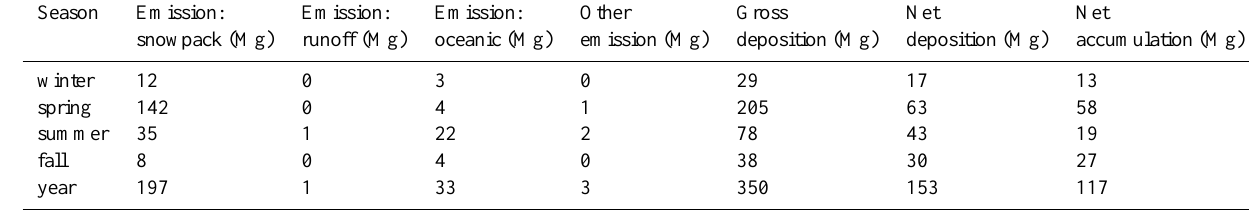
Table 1. Deposition and emission for the area polewards of 66.5°N.